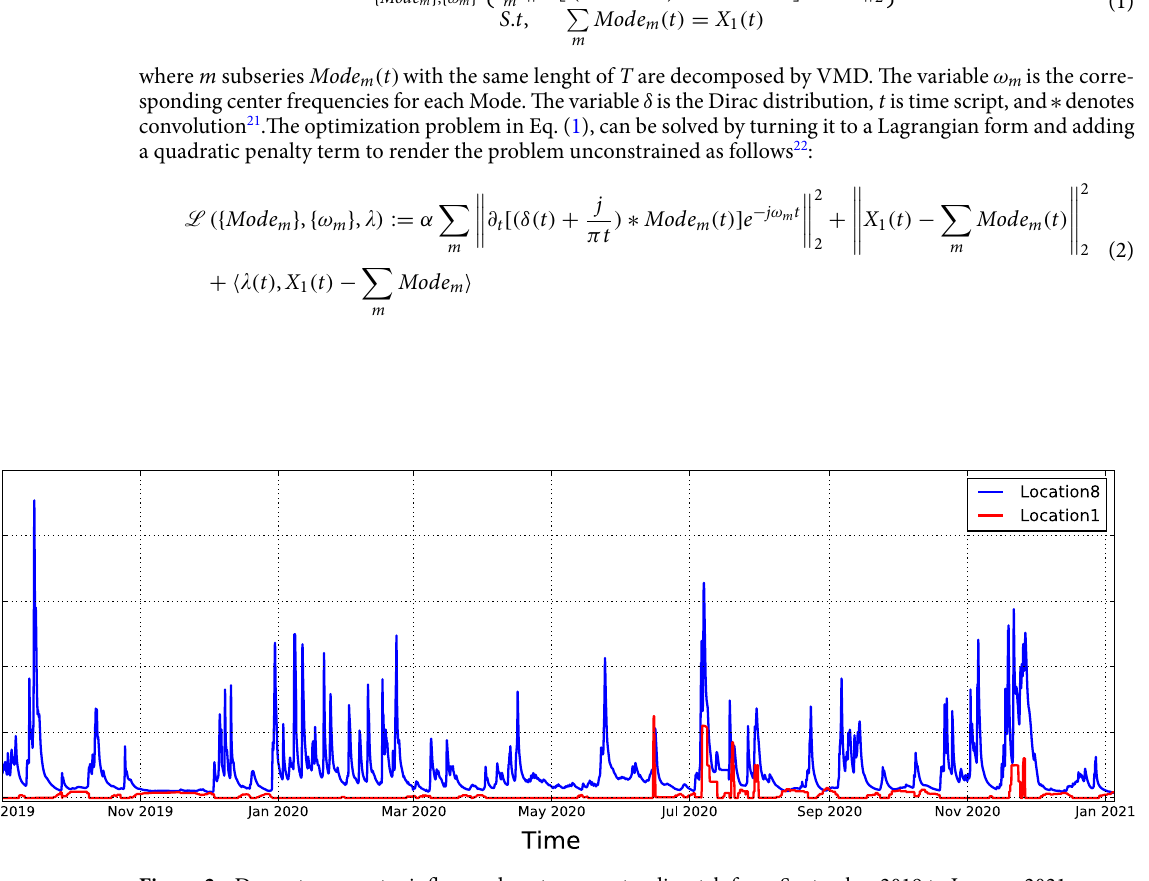
Figure 2. Downstream water inflow and upstream water dispatch from September 2019 to January